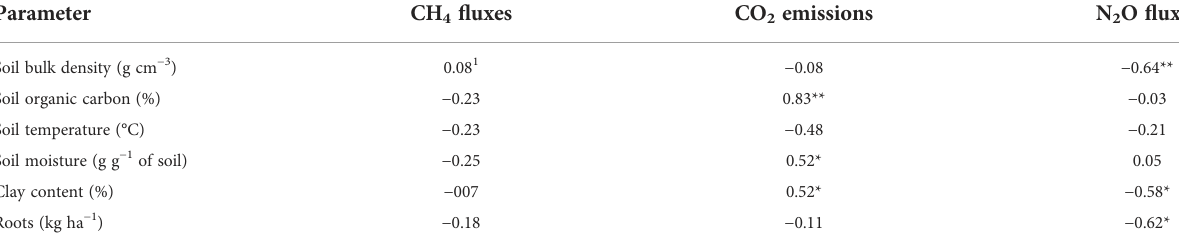
TABLE 3 Correlations between soil/root data and soil GHG emission in kg ha − 1 .